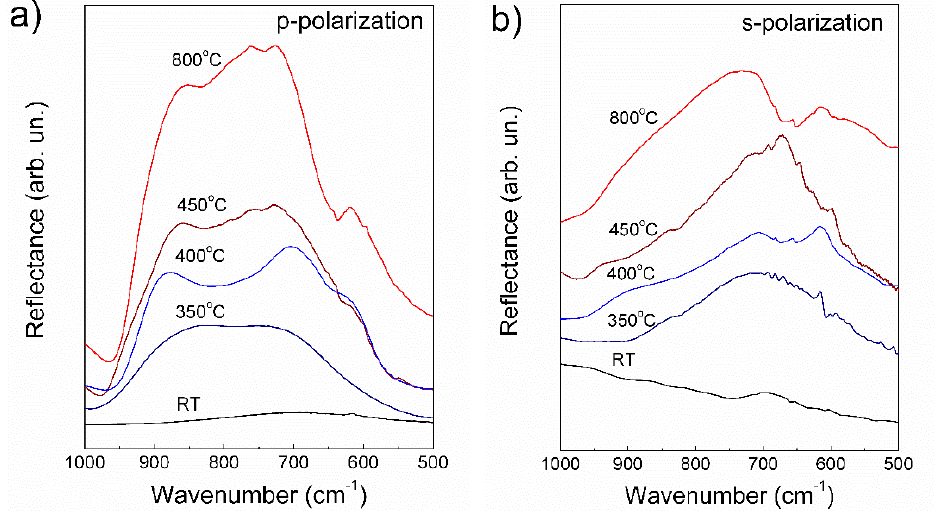
Figure 8. FTIR reflectance spectra of PLD AlN films, investigated in a linearly p -polarized ( a ) and s -polarized ( b ) incident beam.